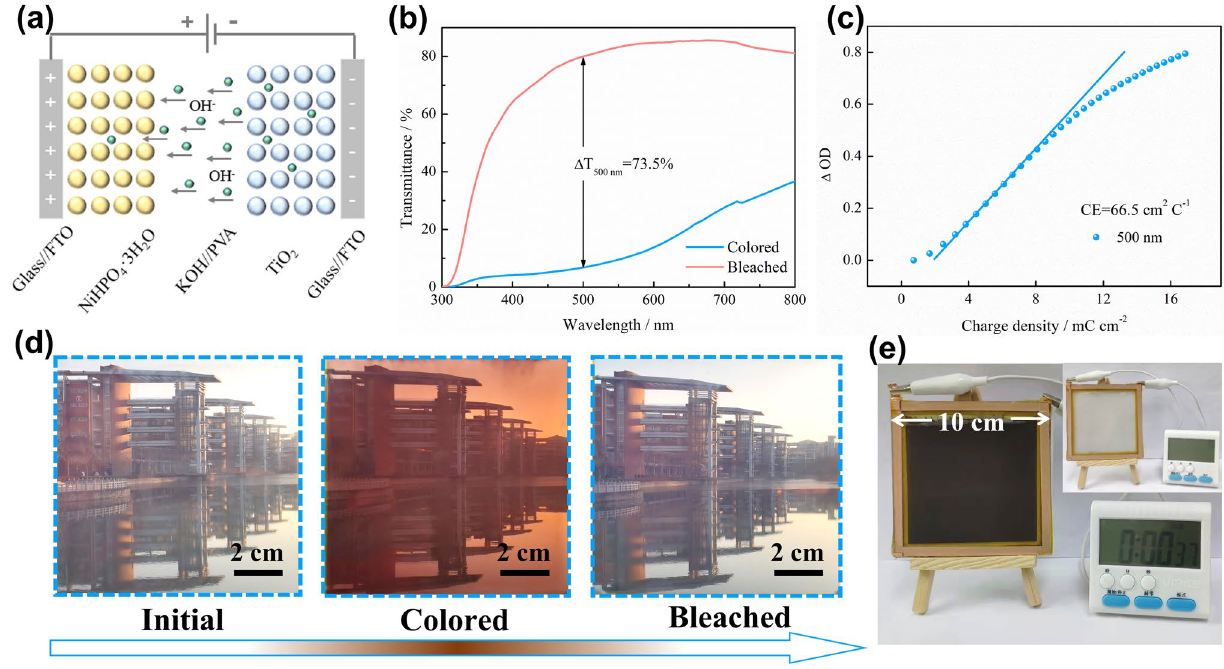
Fig. 5 Electrochromic and energy storage performance of electrochromic energy storage device (EESD). a Configuration of the semi-solid device assembled by NHP film as the electrochromic layer, TiO 2 film as the ion storage layer, and KOH/PVA gel as the semi-solid electrolyte. b Optical transmittance spectra of the colored (2.2 V) and bleached (− 1.5 V) EESD in the wavelength range of 300–800 nm. c Coloration effi- ciency of the as-assembled EESD. Photographs of a 100 cm 2 EC smart window in d the initial, e colored and f bleached states. g The demo of a digital watch driven by the full charged EC smart window (Inset is the uncharged EC smart